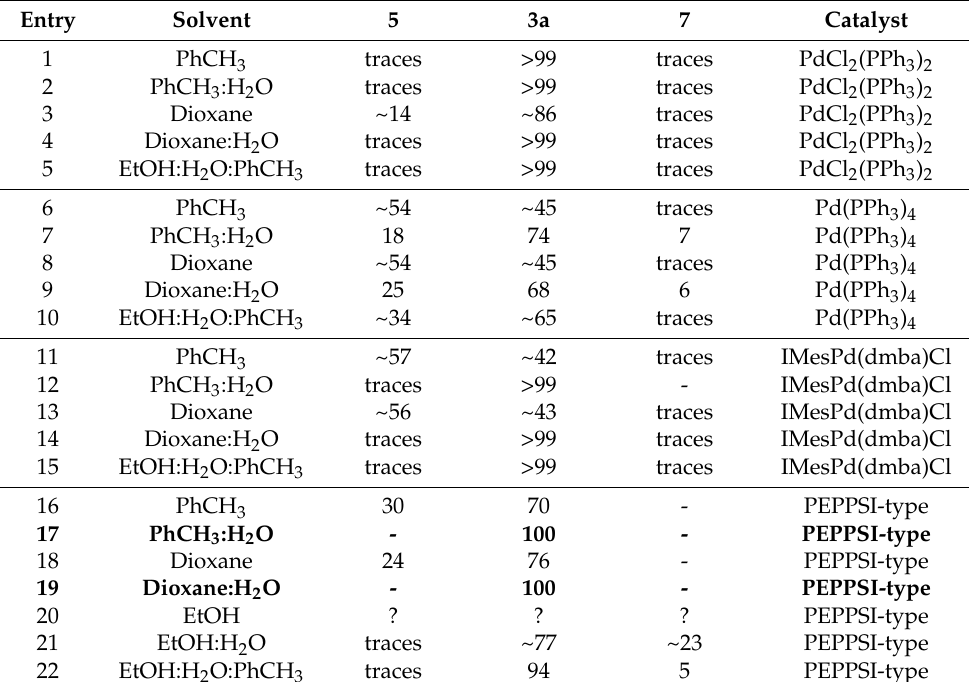
Table 2. Ratio of the formed products in the crude reaction mixture